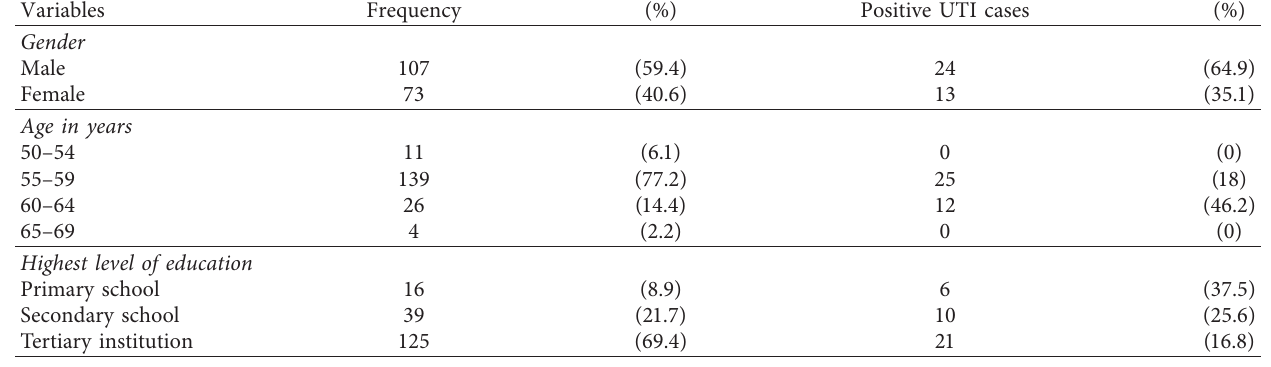
Table 1: Sociodemographic factors associated with UTI among noninsulin-dependent diabetes mellitus.